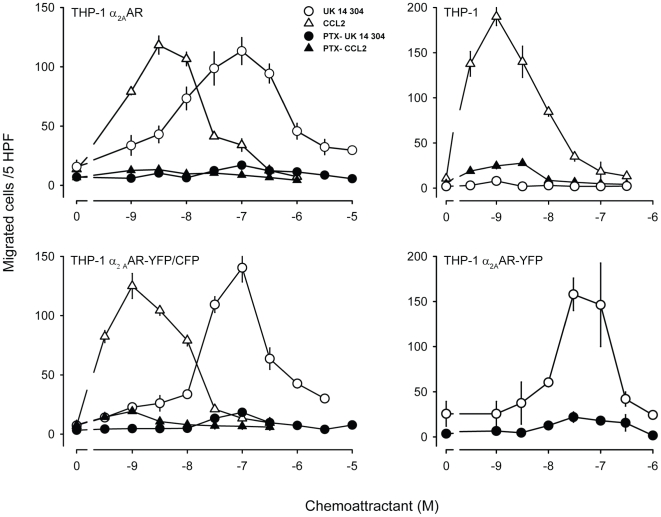
Chemotaxis of THP-1 cells mediated by endogenous and transfected receptors.Either wild type (upper right) or transfected cells (panel labeling denotes expressed receptor) were subjected to chemotaxis assays in modified Boyden chambers for 40 min. Chemotaxis was stimulated with UK 14'304 (circles) or CCL2 (triangles) without (open symbols) or with pretreatment with pertussis toxin (closed symbols).